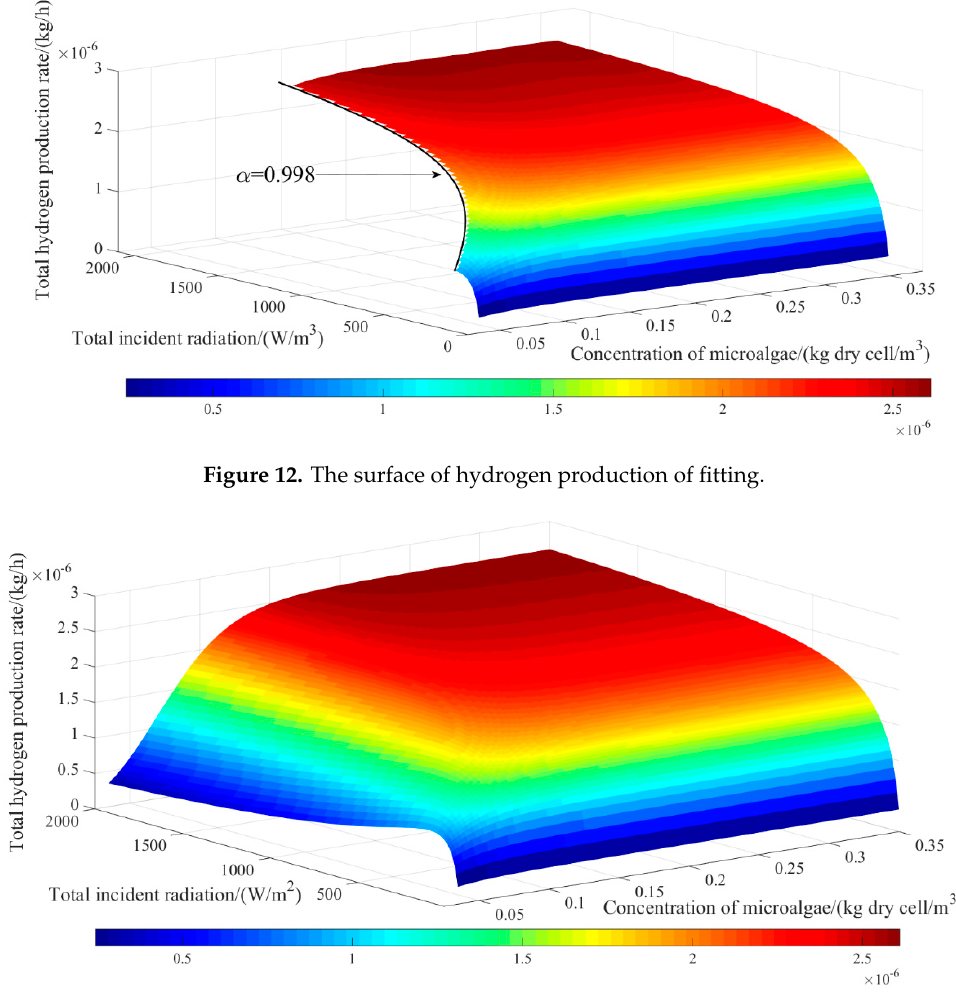
Figure 13. The surface of hydrogen production of simulation.